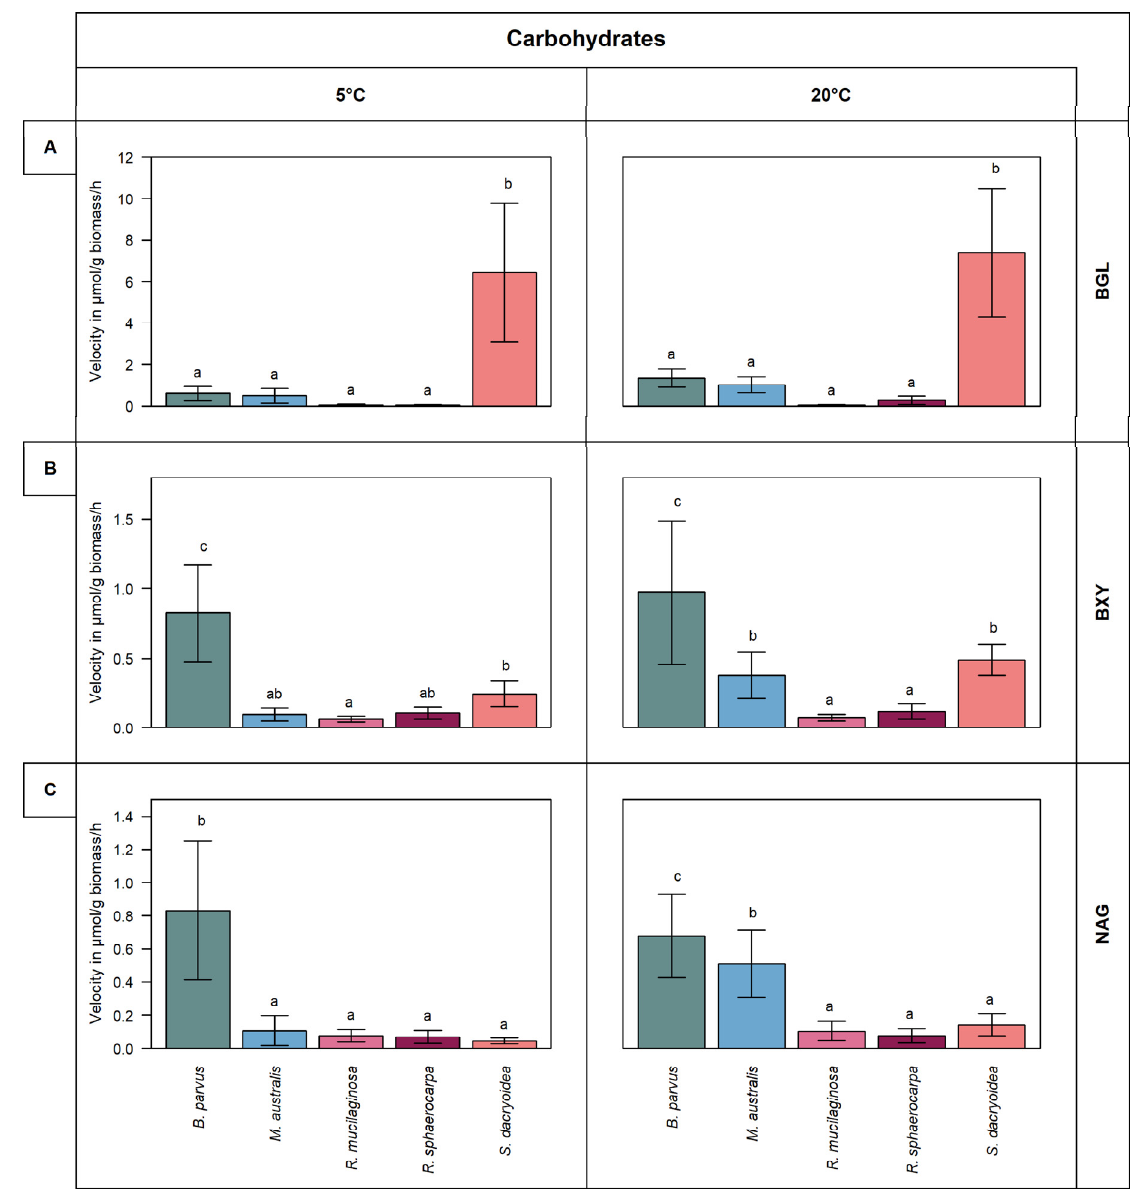
Figure 1. V max in µ mol/g biomass/h obtained from the total enzymatic activity for the substrates representing carbohydrates such as ( A ) β -glucosidase (BGL), ( B ) β -xylosidase (BXY), and ( C ) N -acetyl- β -D-glucosaminidase (NAG) of five marine fungal isolates B. parvus, M. australis , R. mucilaginosa , R. sphaerocarpa , and S. dacryoidea at 5 ◦ C and 20 ◦ C. According to Tukey’s HSD, bars denoted by a different letter (a, b, and c) are significantly different ( p < 0.05), whereas bars denoted by a common letter (ab) are not significantly